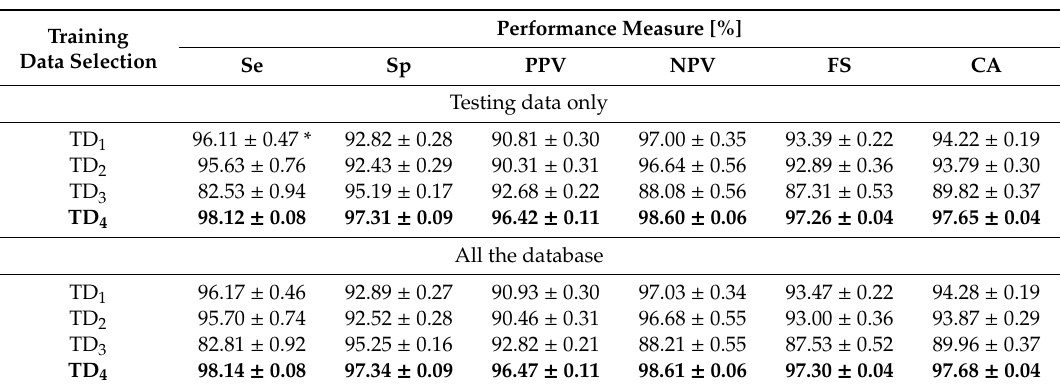
Table 3. The results of MIT-BIH AF database evaluation using the LSVM classifier ( γ = 10, χ = 4 ) trained with the balanced dataset ( N TRN = 17 000), extracted from: the signal of highest FS (TD 1 ), mixed signals of the highest Se and FS (TD 2 ), mixed signals that were characterized by the highest Se, Sp and FS (TD 3 ), and all the signals (TD 4 ). The best results obtained for testing data only and for all data are in boldface.